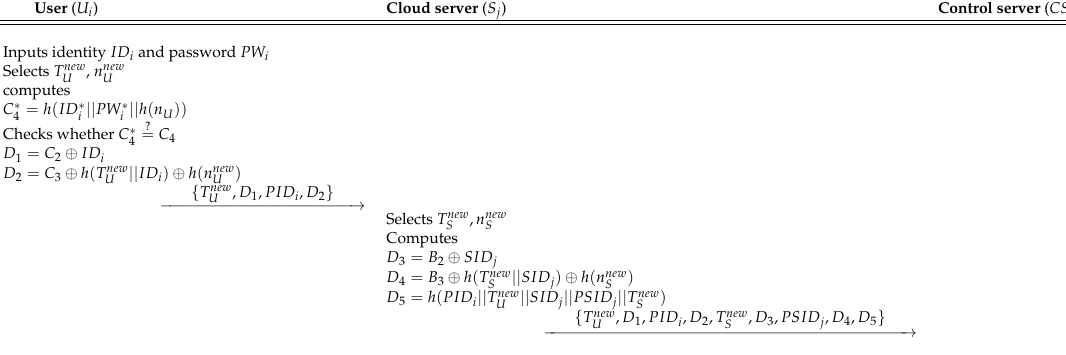
Figure 3. Login process of the Pelaez et al.’s scheme